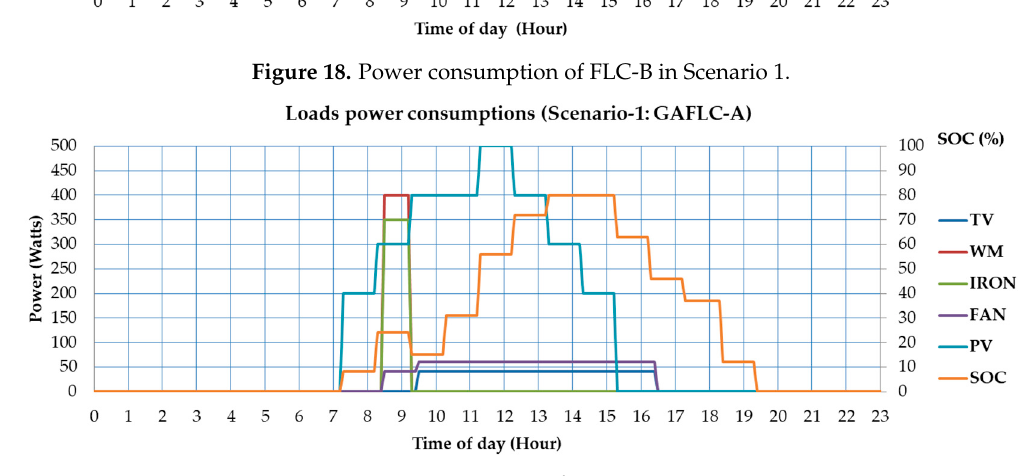
Figure 19. Power consumption of GAFLC-A in Scenario 1.